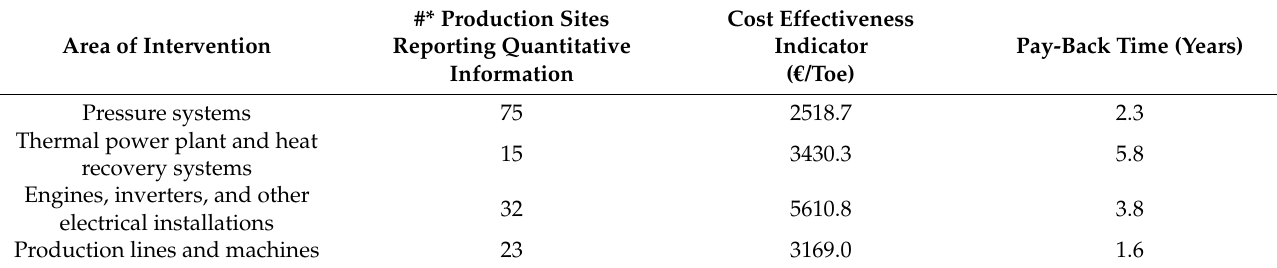
Table 9. Pay-back time for each area of intervention.